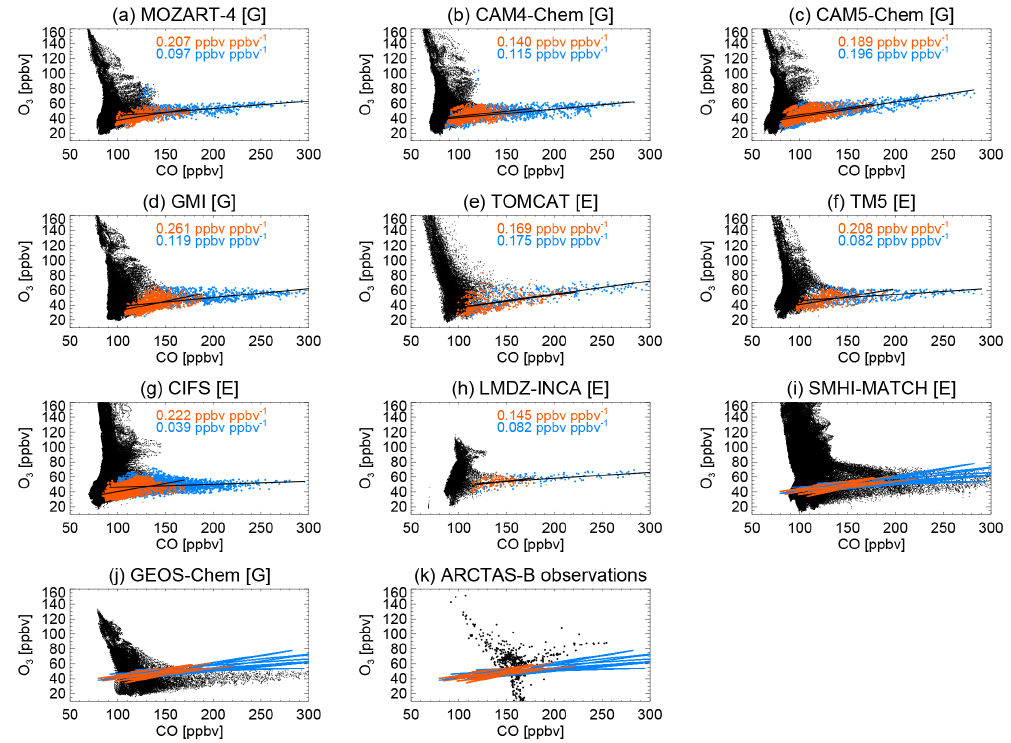
Figure 5. July 2008 monthly mean O 3 vs. CO from POLMIP model simulations coloured by fire influence and relative age of air since emission. Black: all points north of 50 ◦ N, with 850hPa > pressure > 250hPa. Coloured points show model grid boxes where the fire- emitted fixed-lifetime CO tracer contributes more than 66% of the total (fire + anthropogenic) tracer mixing ratio. Blue and red points denote younger than average and more aged than average of these points respectively, as diagnosed by the ln ( [ C 3 H 8 ] / [ C 2 H 6 ] ) concentration ratio. Models that did not simulate fixed-lifetime tracers, or do not carry [C 3 H 8 ] explicitly, do not have coloured points, but instead show slopes from linear regressions of the coloured points from the other models (red and blue lines). Blue and red text give (cid:49) O 3 /(cid:49) CO slope values from linear regressions of the youngest and most aged populations respectively. Letters in square brackets denote the meteorological analysis data used to drive the models – E: ECMWF; G: GEOS-5. Panel (k) shows ARCTAS-B aircraft